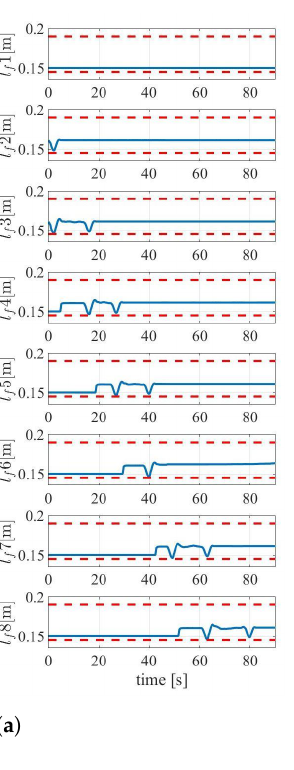
Figure 8. Experimental results of the link length. ( a ) The actual forward link length ¯ l f . ( b ) The forward link length on the projection model l f . ( c ) The actual backward link length ¯ l b . ( d ) The backward link length on the projection model l b